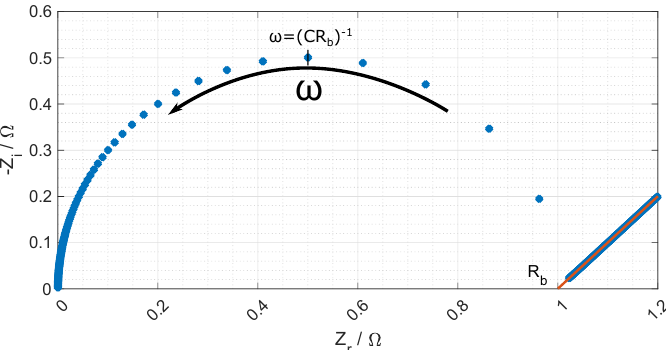
Figure 8. Nyquist plot of Equation (18), and where the ohmic resistance of the membrane is